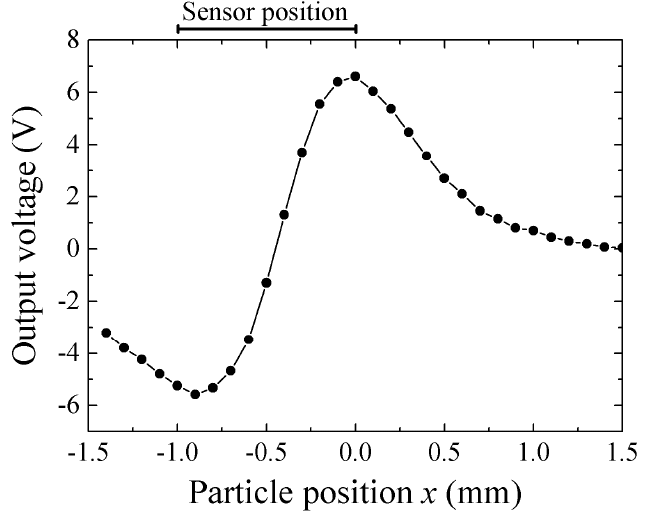
Figure 24. Result of measurement of scanned magnetic small particle along sensor longitudinal direction [21].